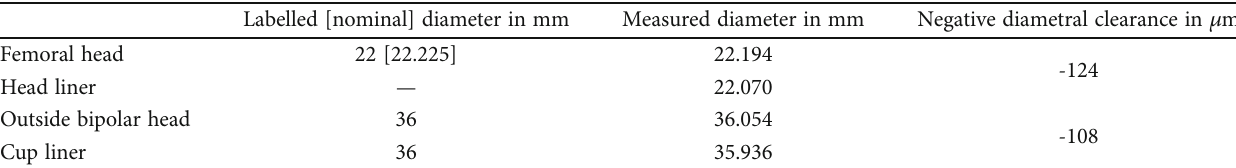
Figure 8: (a) Heavily scratched area of the head with (b) magni fi cation of the local surface damage. Table 1: Diameters and negative diametral clearances of bearing